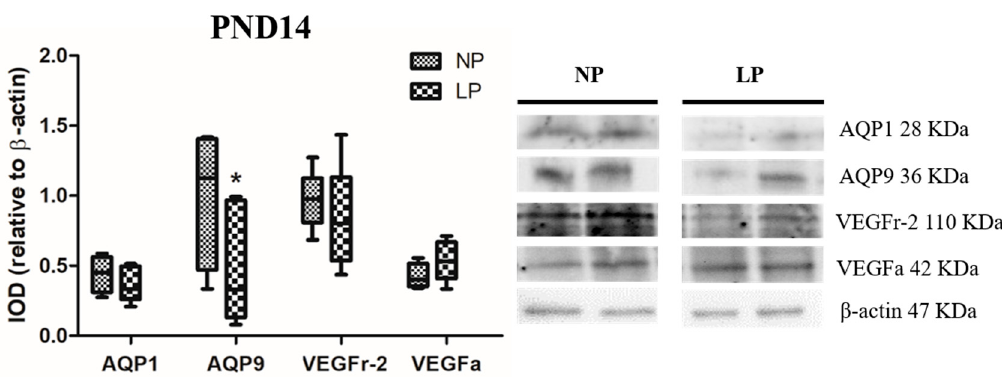
Figure 3. Expression of AQP1, AQP9, VEGFr-2 and VEGFa in the epididymis of NP and LP animals at PND14. Data are expressed as the mean ± S.E.M. * p < 0.05. Mann–Whitney test.